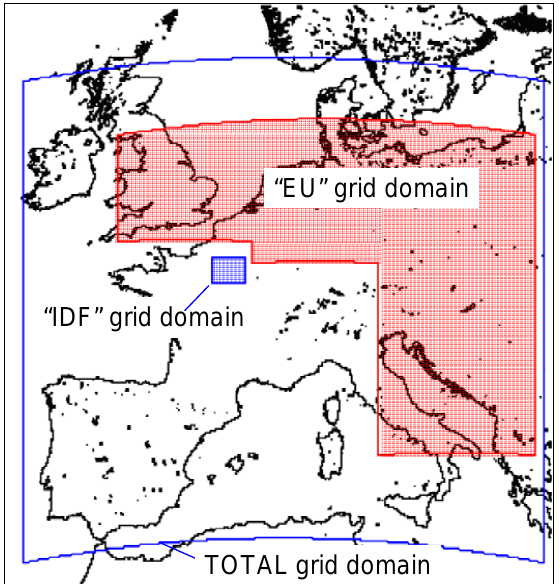
Fig. 10. Grid domain of the chemistry transport model CHIMERE. In blue the “IDF” domain comprises the Ile-de-France region sur- rounding Paris; in red the “EU” domain comprises part of North- Western and Central